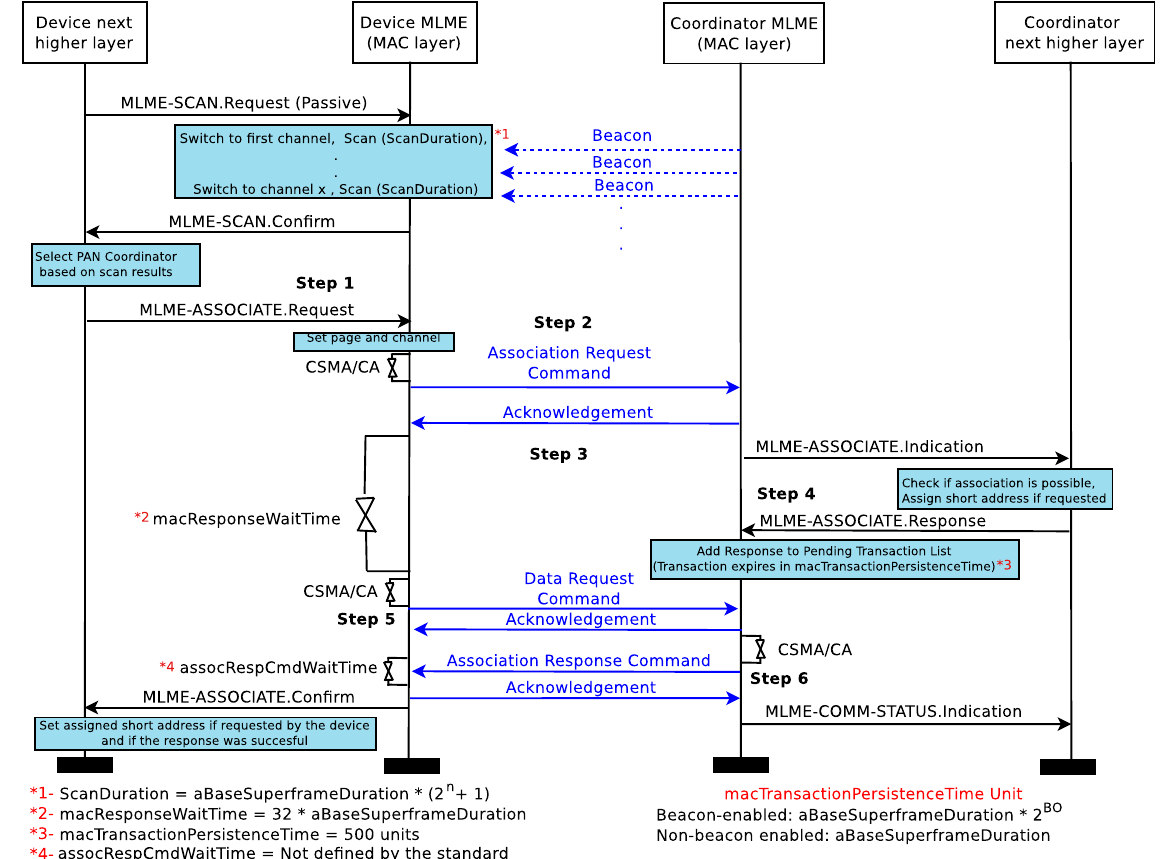
Figure 4. Message sequence chart for bootstrap: passive scan and